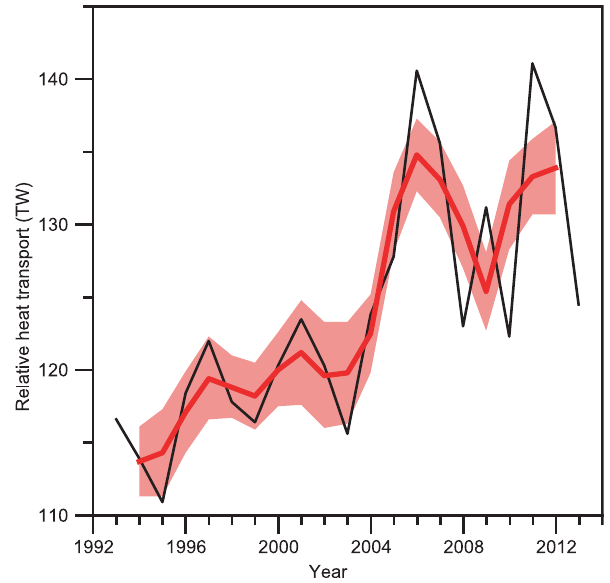
Figure 9. Interannual variation of relative (to 0 ◦ C) heat transport 1993–2013. Annually averaged transport (black curve) and 3-year averaged transport (red curve) with the red background representing ± one standard error over each 3-year